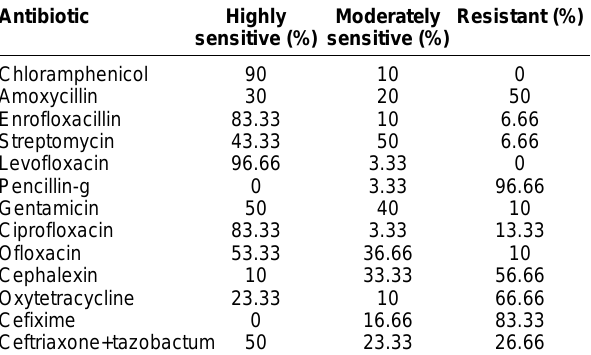
Table-5. Antibiogram of E. coli isolates